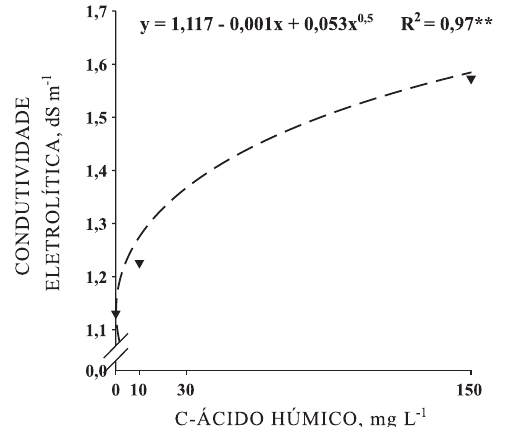
Figura 3. Condutividade eletrolítica na solução nutritiva, em função da aplicação de concentrações de C-ácido húmico.